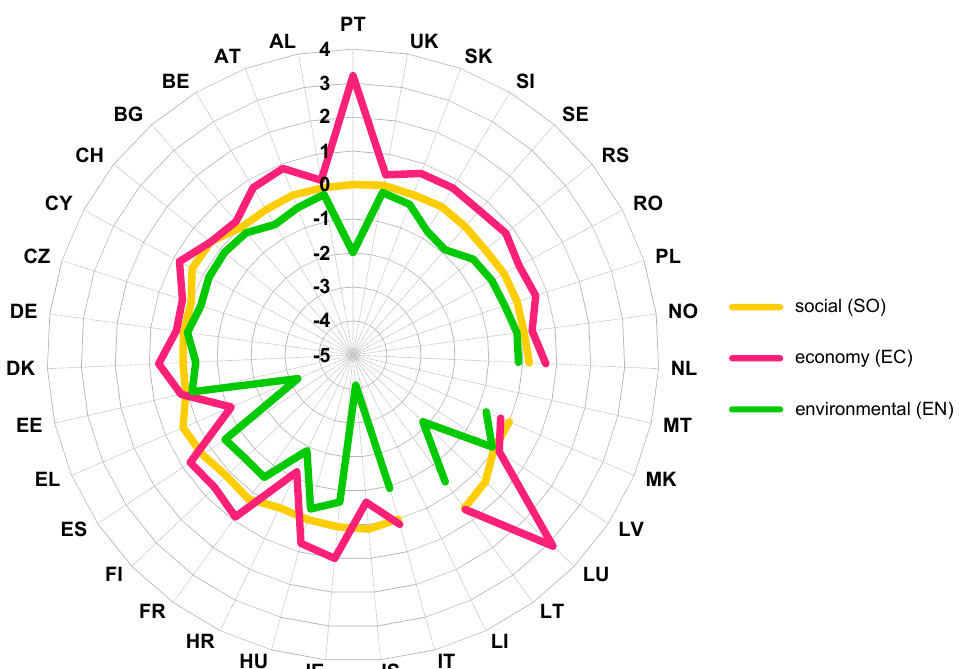
Figure 3. Sustainability assessment of local change directions in big cities.